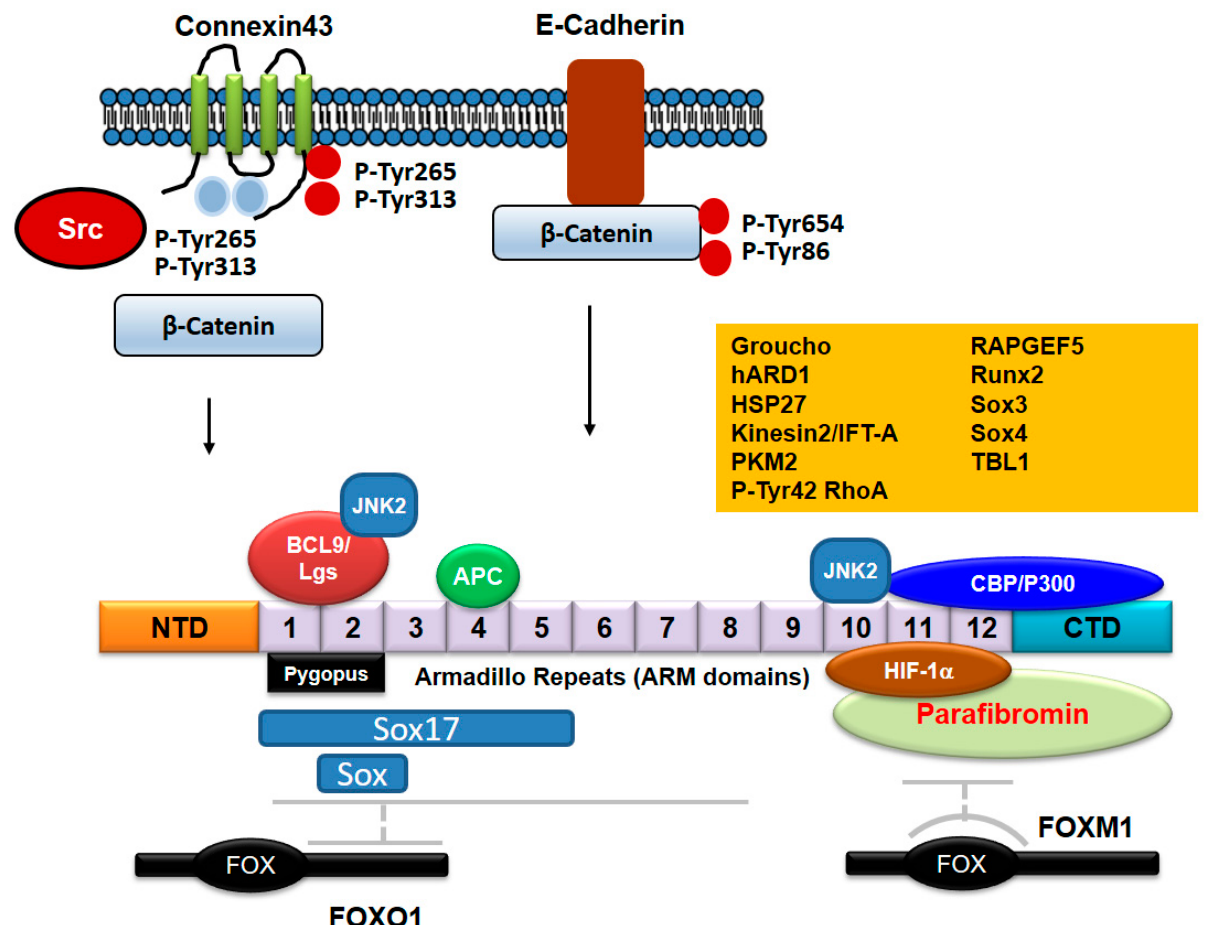
Figure 5. Proteins binding to β -catenin. APC/Axin binds to ARM domains 3-7 of β -catenin. C-terminal domain of FOXO1 binds with ARMs 1-8 of β -catenin, whereas FOXM1 binds to ARMs 11-12 of β -catenin. Pygopus and BCL9/Lgs proteins bind to ARMs 1-2. CBP/P300 binds to C-terminal domain of β -catenin in addition to ARMs 11-12. Sox17 binds to β -catenin ARMs 1-5, but it is not clear that other Sox family proteins bind to which ARMs. JNK2 binds to both ARM domains 2 and 10. HIF-1 α binds with β -catenin ARMs 10-12. Parafibromin binds to ARMs 10-12 including C-terminal domain. The exact regions of β -catenin domains binding with other proteins such as Groucho, hARD1, HSP27, Kinesin2/IFT-A, PKM2, p-Tyr42 RhoA, RAPGEF5, Runx2, and TBL1 still remain to be described. β -catenin binds to E-cadherin, but is released from E-cadherin by phosphorylation at Tyr86 and Tyr654 residues by Src. Connexin43 phosphorylated by Src at Tyr654 and Tyr86 residues reduces β -catenin interaction and connexin43 phosphorylated by Src at Tyr247 and Tyr265 residues reduces Src oncogenic